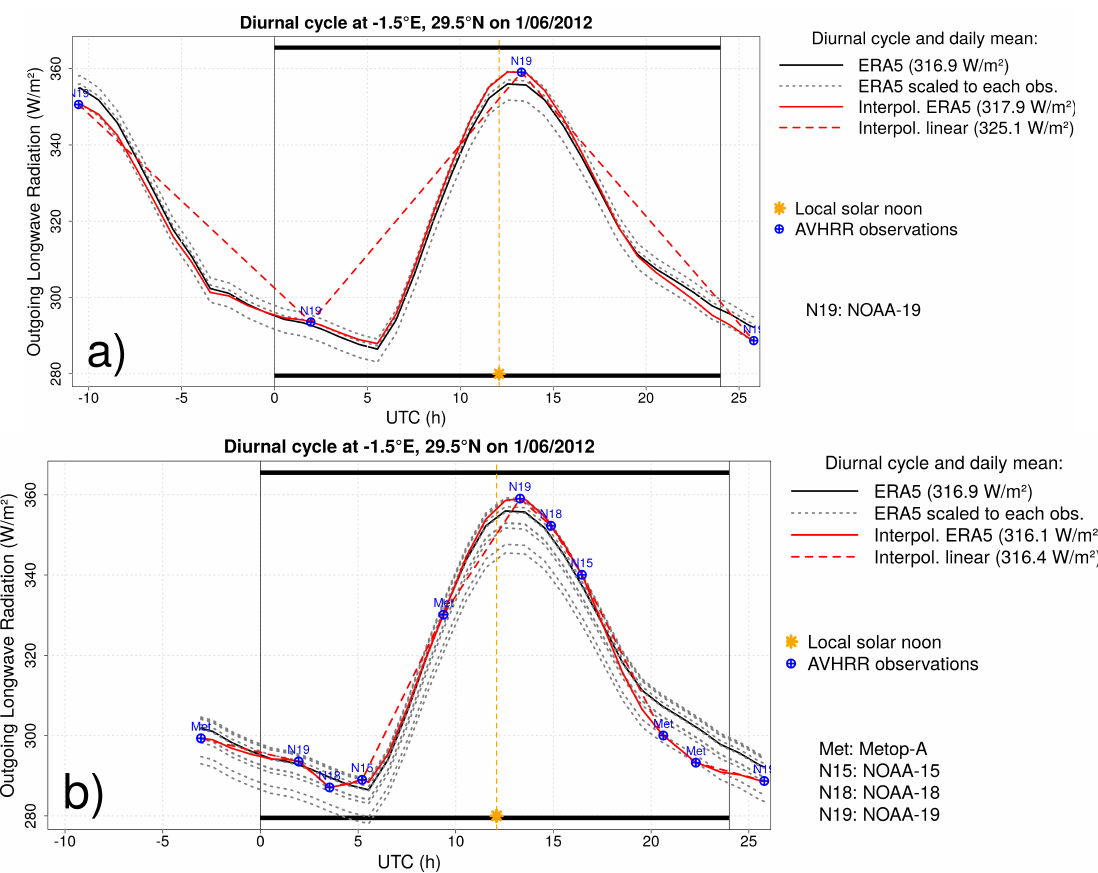
Figure 5. Illustrative example of an OLR diurnal cycle in a single grid box (land cover: desert), modeled using a single satellite NOAA-19 ( a ) and using all available satellites ( b ). Note that the actual daily mean is based on the “UTC day”, as indicated on the top and bottom of the graph (0–24